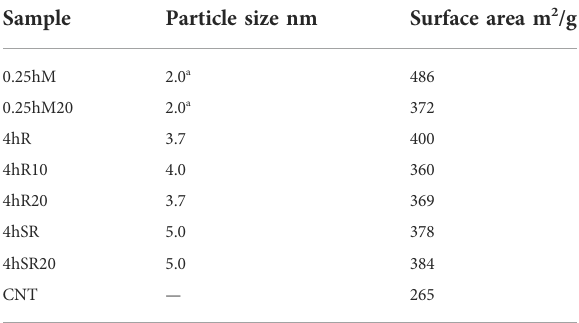
TABLE 2 Particle size and speci fi c surface area of TiO 2 and TiO 2 /CNT composites.